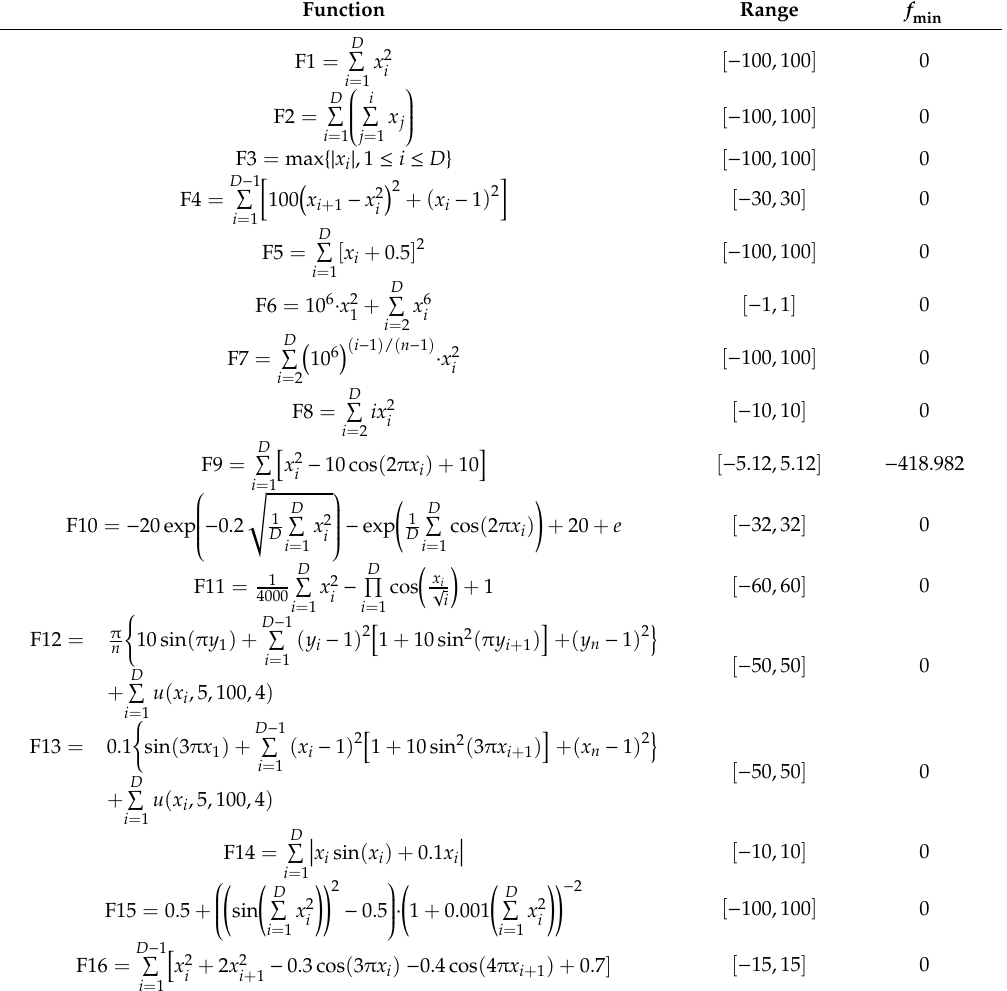
Table A1. Benchmark